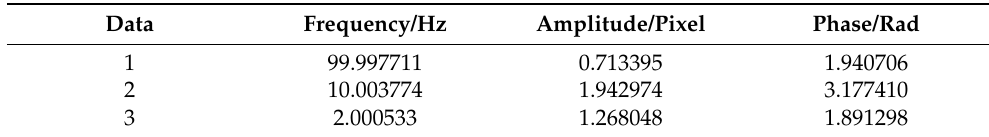
Figure 16. Analysis results of 2-Hz jitter detection curve after interpolation by sequential disparity maps. ( a ) Fourier analysis results; ( b ) Fitting results. Table 3. Fitting results of relative jitter error curves of three different frequencies by sequential disparity